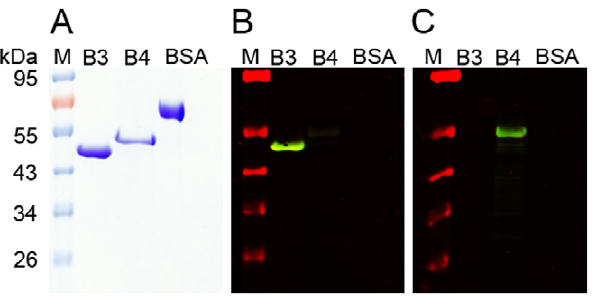
Figure 2. Specificity of mouse antisera raised against recom- binant SMSB3 and SMSB4. The purified SMS proteins and BSA (used as a non-related control) were electrophoresed on SDS-PAGE and stained with Coomassie blue R-250 (A) and then immunoblotted with the anti-sera raised against SMSB3 (B) and SMSB4 (C), confirming the specificity of the antibodies and lack of cross-reaction with BSA.